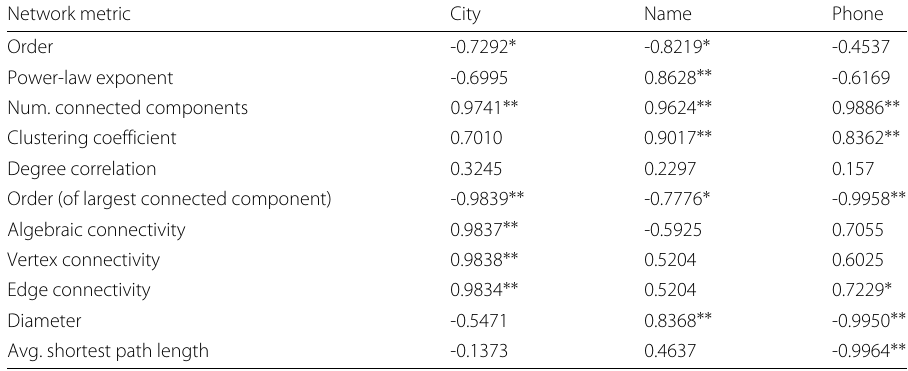
Table 6 Pearson correlation coefficients between precision and network metrics Network metric